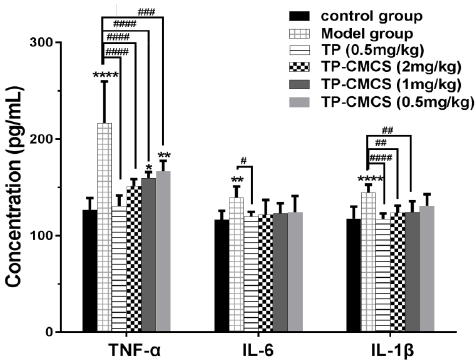
Figure 9. The changes on level of serum pro-inflammatory cytokines. * Represents p <0.05, ** represents p <0.01, **** represents p <0.0001 vs conctrol group; # represents p <0.05, ## represents p <0.01, ### represents p <0.001, #### represents p <0.0001 vs model group.